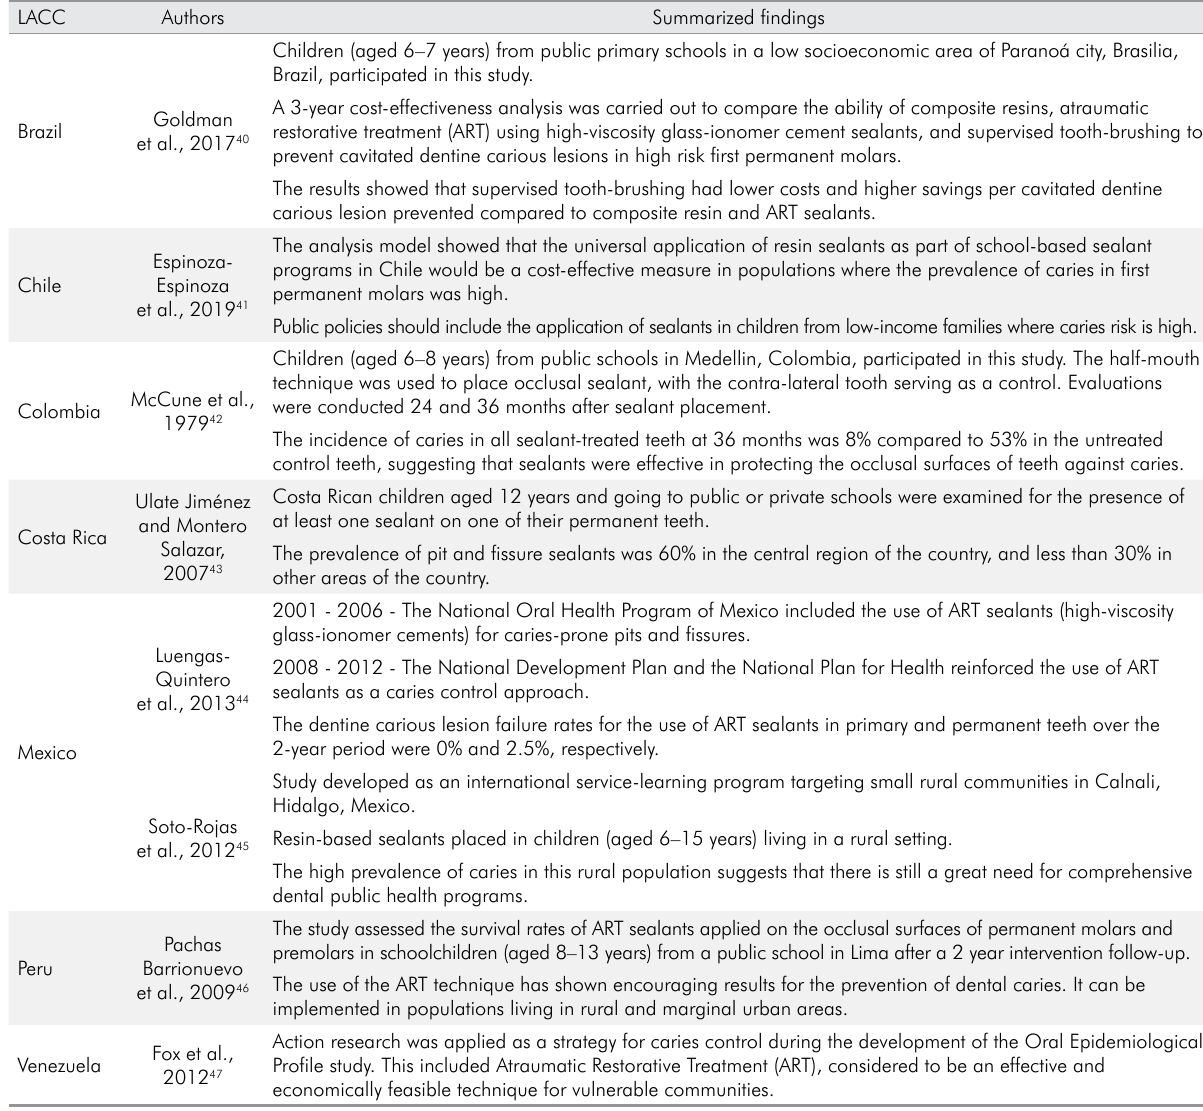
Table 3. The use of occlusal sealants for dental caries control in Latin American and Caribbean countries (LACCs).